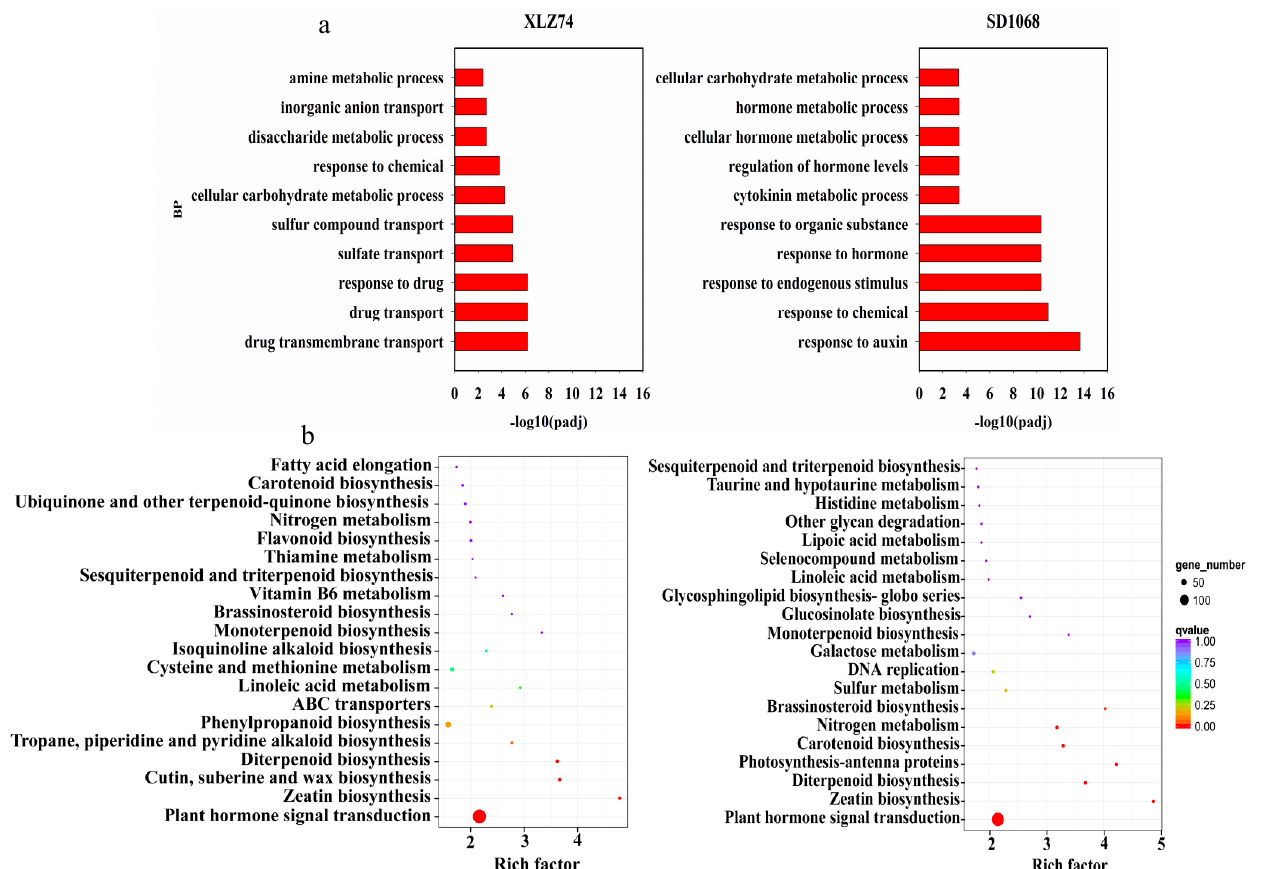
Figure 4. Gene Ontology (GO) enrichment and Kyoto Encyclopedia of Genes and Genomes (KEGG) pathway analyses of DEGs between MC and water treatments in the two varieties. ( a ) Enriched biological process GO terms (padj < 0.001). X-axis shows -log10 (padj) value, and Y-axis shows the top ten enriched GO terms. ( b ) Enriched KEGG pathways. For each variety, all DEGs identified at the three time points were used in functional classification. Y-axis shows the KEGG pathways, and X-axis shows the Rich factor. The size and color of each circle represent the number of enriched genes in the corresponding pathway and the − log10 ( q value) value, respectively.